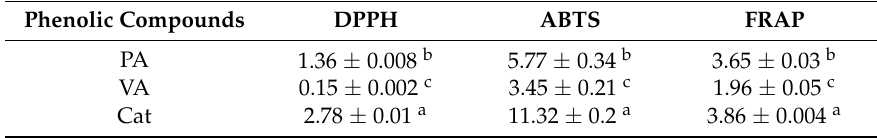
Table 5. Antioxidant activity of single phenolic compounds determined by DPPH, ABTS, and FRAP method, and expressed as the equimolar antioxidant activity of each phenolic compound with respect to the Trolox standard.